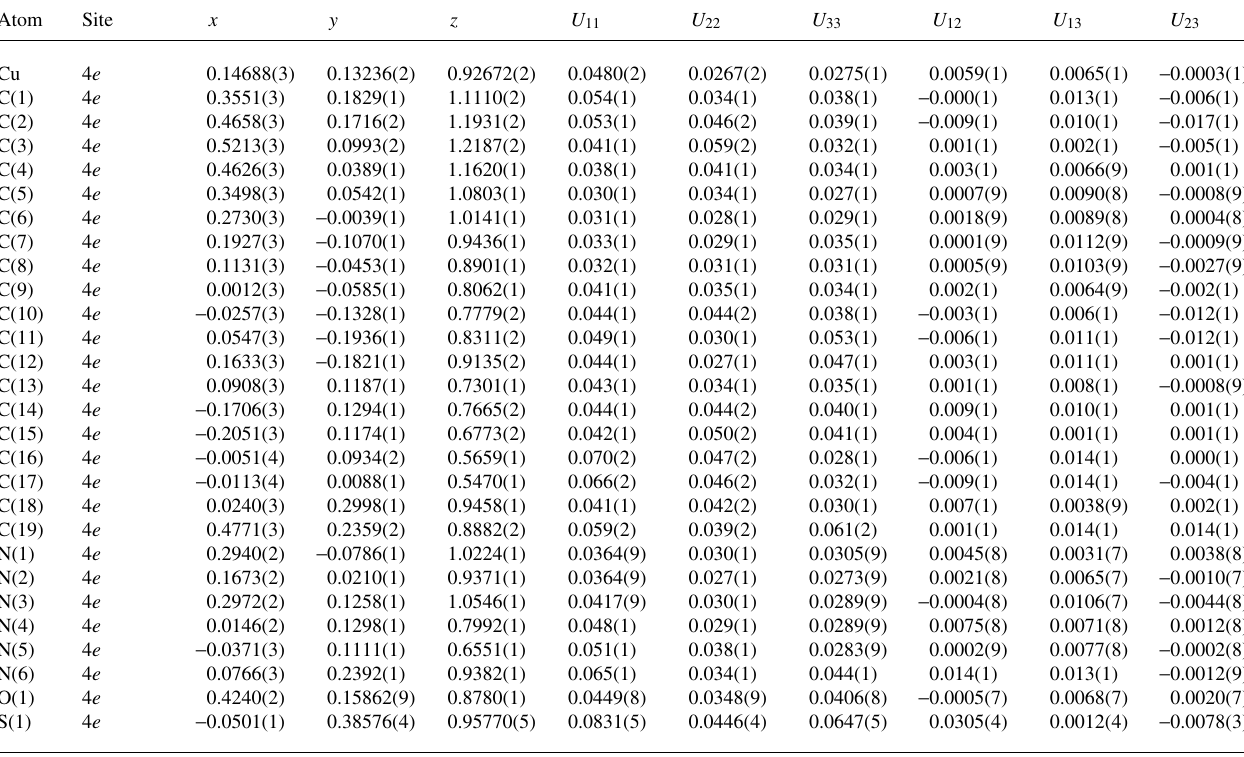
Table 3. Atomic coordinates and displacement parameters (in Å 2 ) .